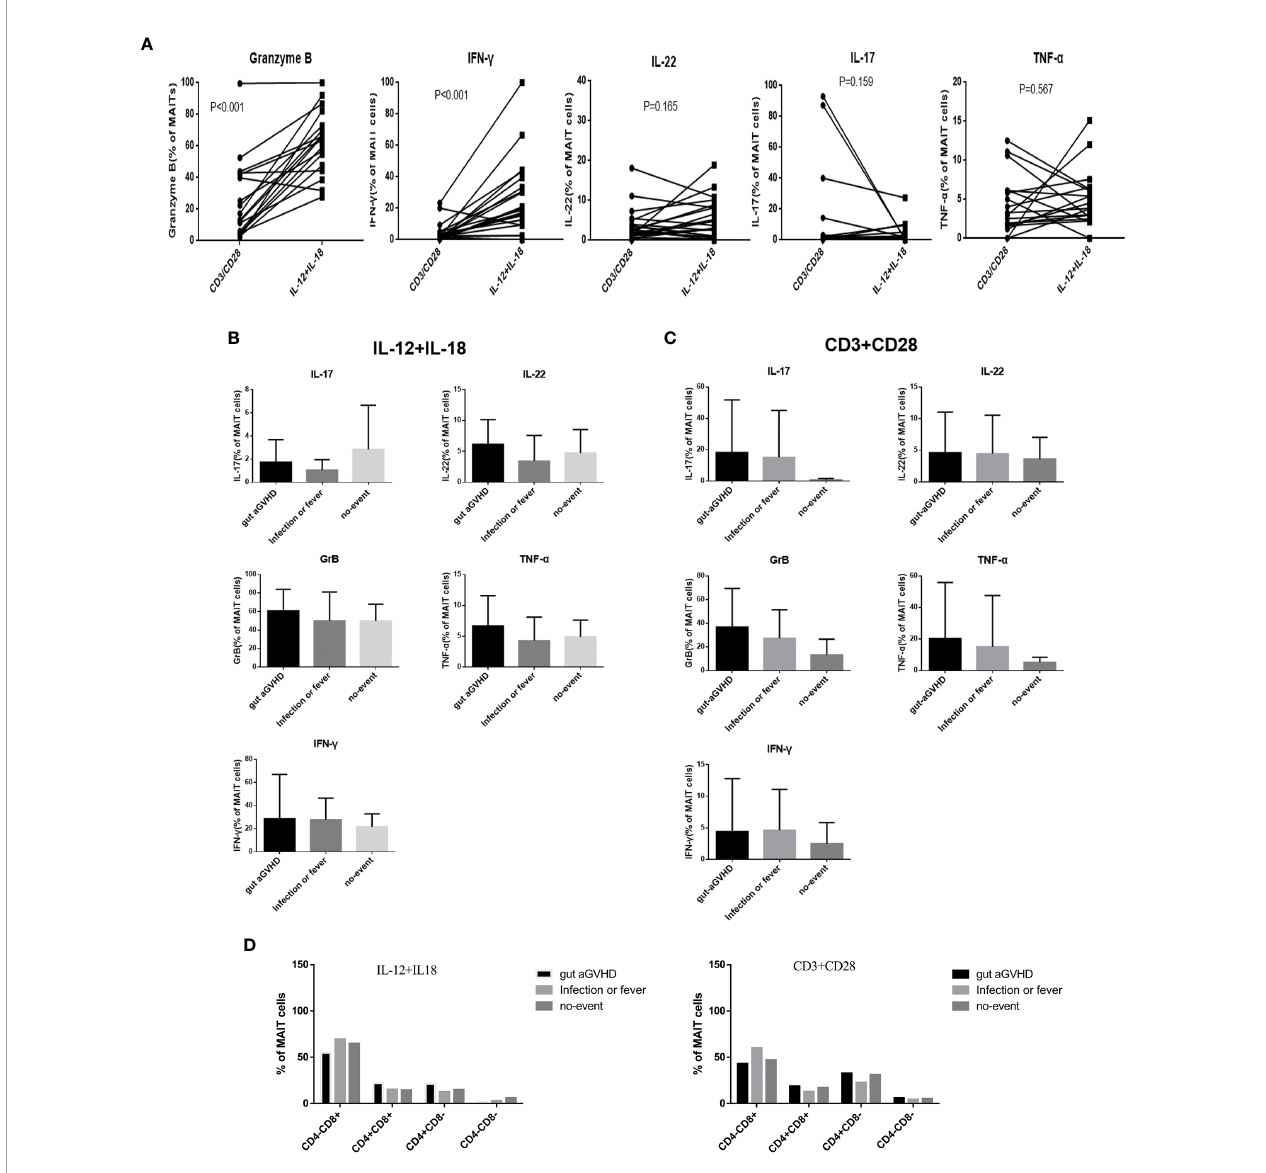
FIGURE 4 | The comparison of the cytokine expression of mucosa-associated invariant T (MAIT) cells in peripheral blood under different stimulation signals in vitro among the gut acute graft-versus-host disease (aGVHD) group (n = 8), infection or fever group (n = 10), and no-event group (n = 7). (A) The comparison of the cytokine expression of MAIT cells under different stimulation signals in vitro . (B) The comparison of the cytokine expression of MAIT cells under interleukin (IL)-12/IL18 stimulation in vitro among the gut aGVHD group (n = 8), infection or fever group (n = 10), and no-event group (n = 7). (C) The comparison of the cytokine expression of MAIT cells under cluster of differentiation (CD)3/CD28 stimulation signals in vitro among the gut aGVHD group (n = 8), infection or fever group (n = 10), and no- event group (n = 7). (D) The comparison of cytokine expression under IL-12/IL18 stimulation and CD3/CD28